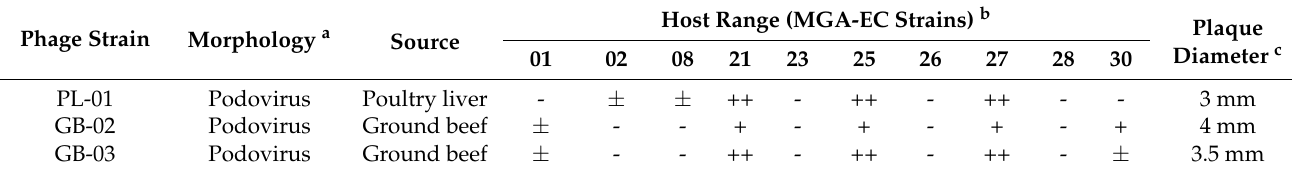
Table 2. Characterization of bacteriophages with lytic activity against biofilm-forming E. coli strains.